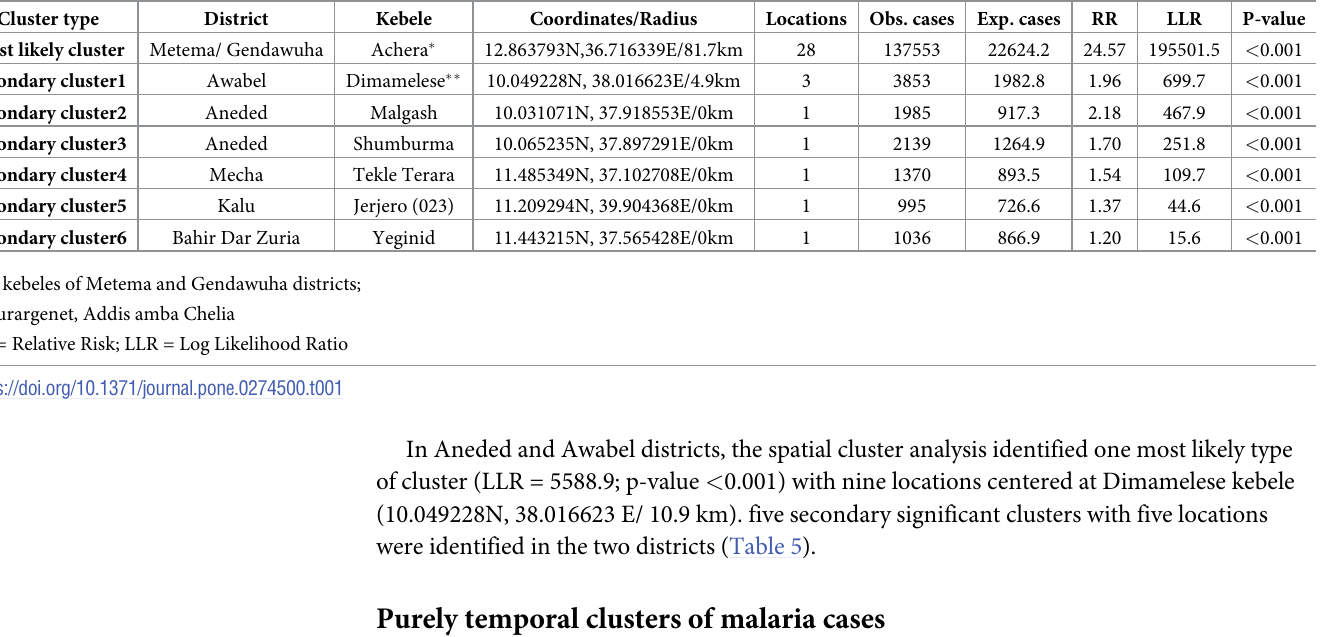
Table 1. Purely spatial clusters of malaria cases in the study areas between epi week 37/2013 and 38/2018. Cluster